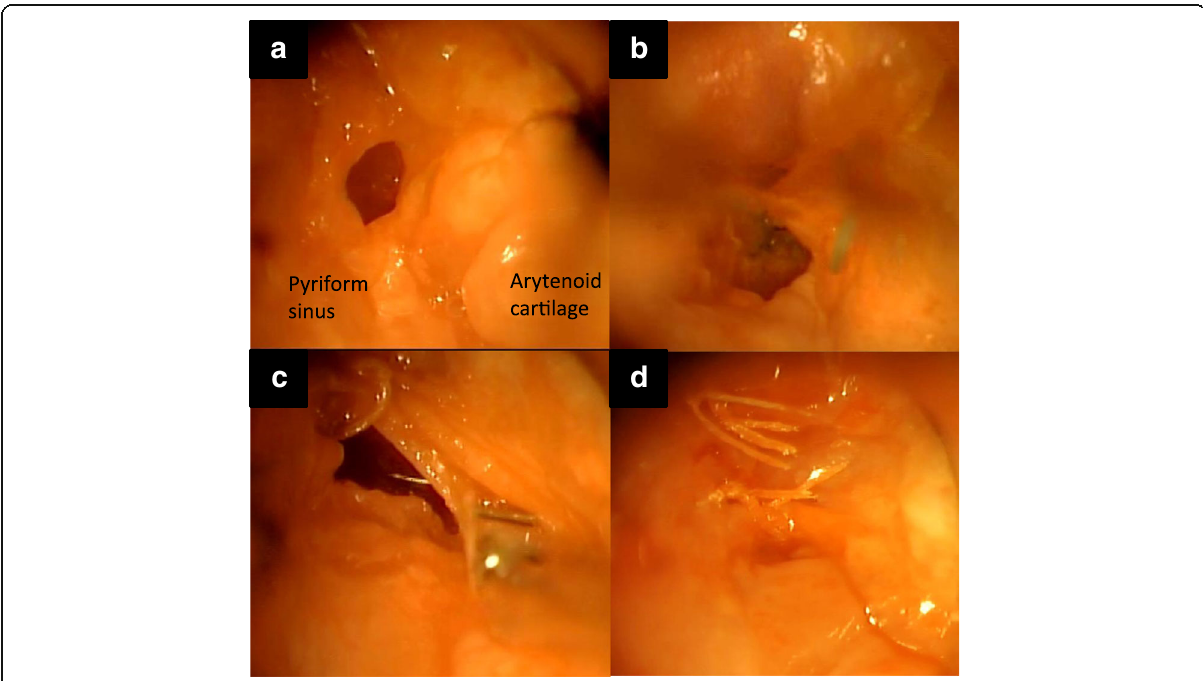
Fig. 3 a Direct laryngoscopy shows the internal orifice at the left pyriform sinus. b The internal orifice is fragile owing to inflammation. A circumferential incision is made around the internal orifice using scissors and cupped forceps. c The mucosal incision is sutured using 4 – 0 Vicryl®. d The pyriform